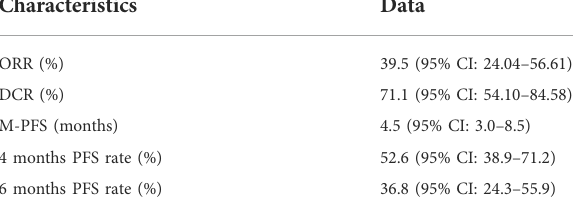
TABLE 3 Clinical ef fi cacy in all